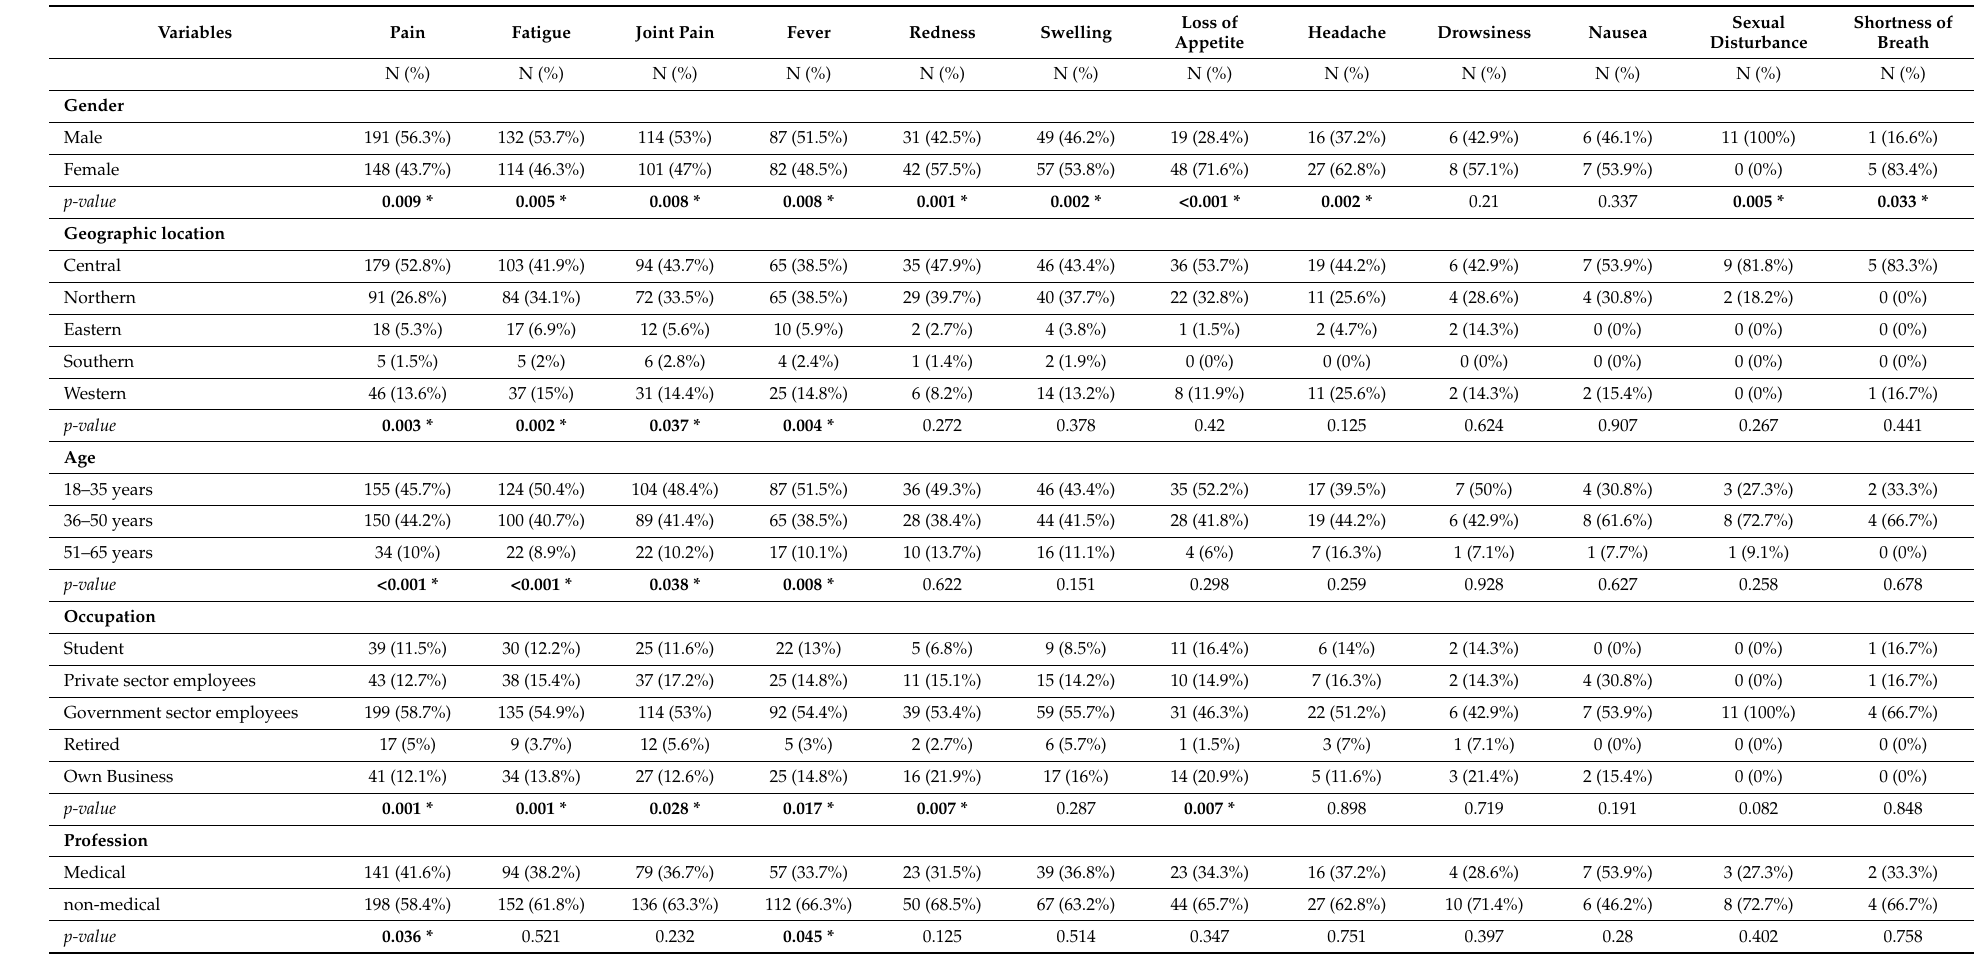
Table 4. Association of individual side effects among